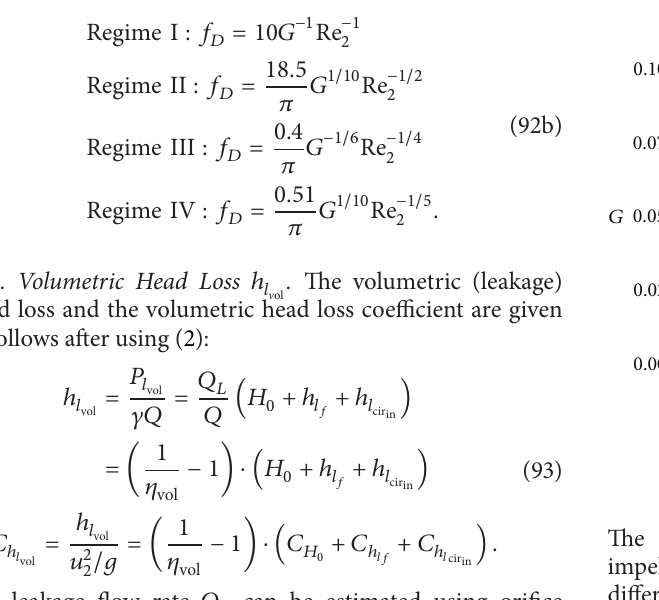
Figure 7: Disk and wearing ring clearances.